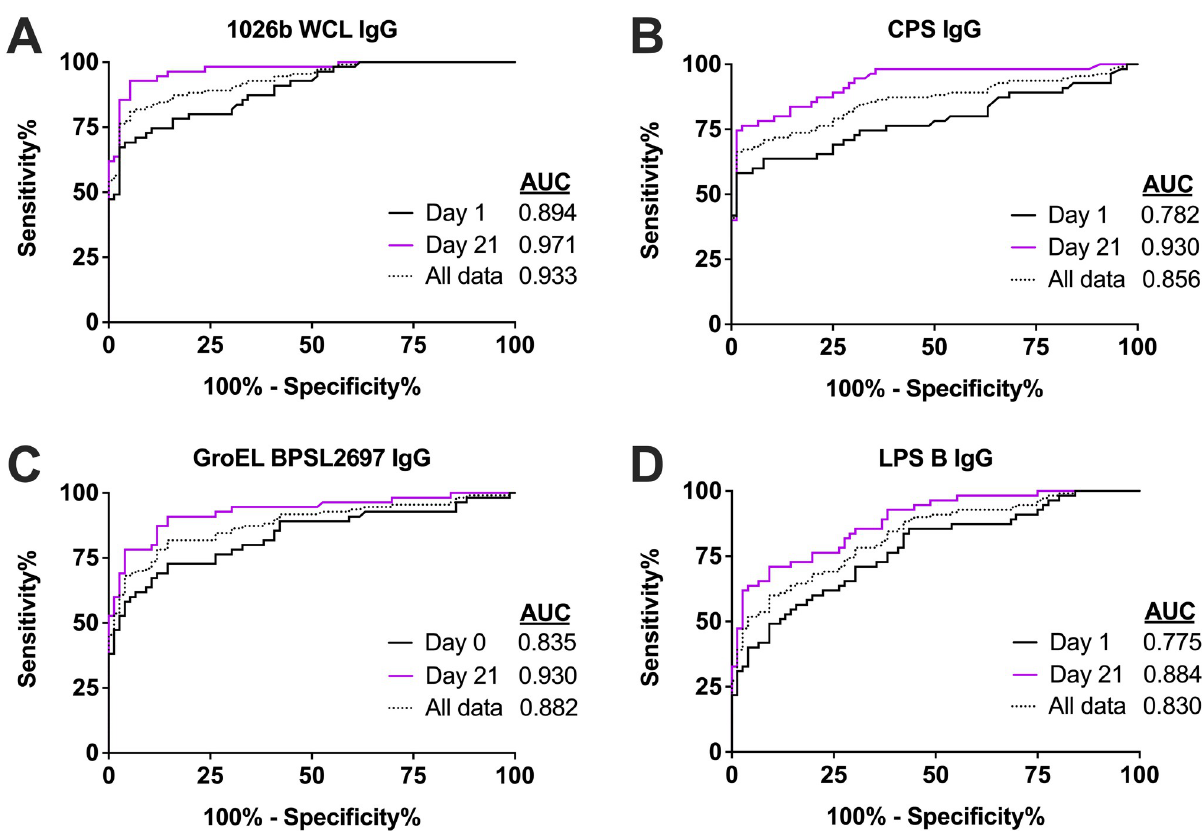
Fig 3. ROC analysis of B . pseudomallei lysate (multiple antigens—A) and single antigens (B-D) selected by day 21 area under the curve (AUC) analysis performance. Responses to 1026b WCL (A), CPS (B), GroEL (C), and LPS B (D) antigens are shown using non-melioidosis human sera samples compared with day 0 (black), day 21 (purple), or all melioidosis-confirmed patient samples (dashed). The area under the curve (AUC) value for each data set is shown.